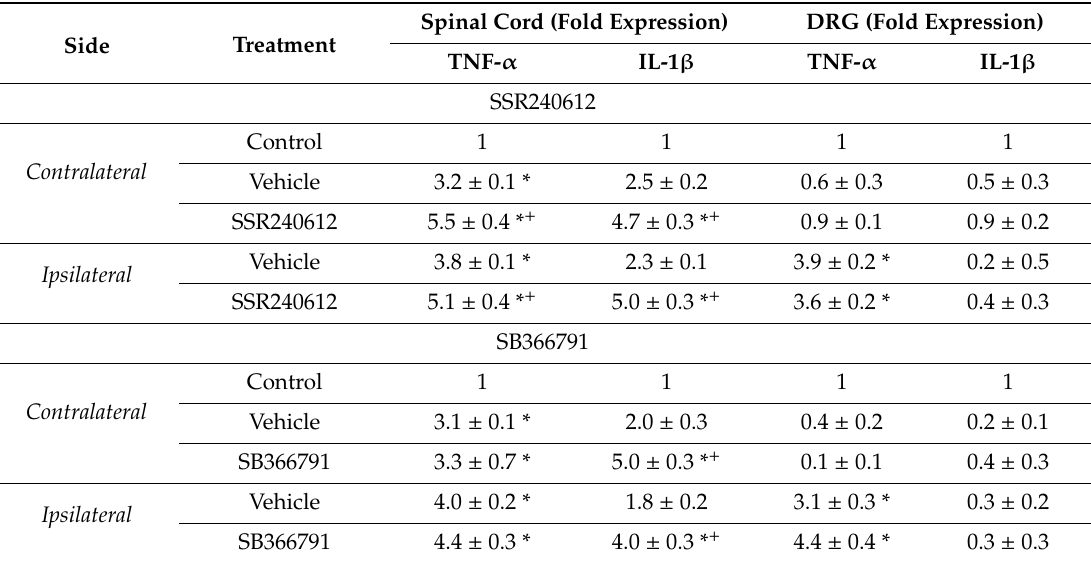
Table 1. TNF- α and IL-1 β mRNA levels in the Spinal Cord and dorsal root ganglion (DRG)